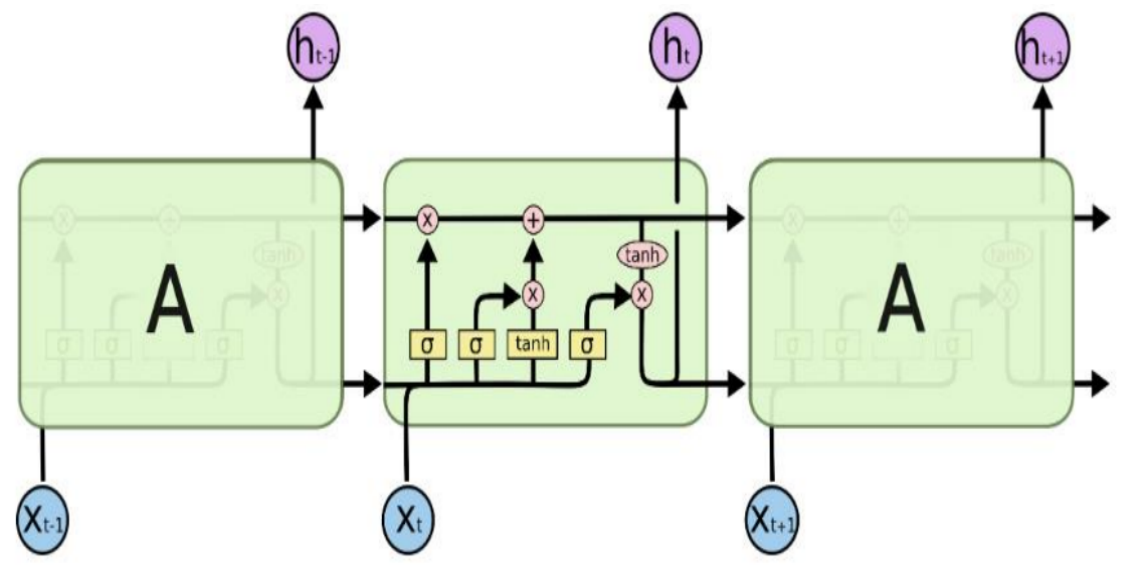
Figure 7. Framework 3-LSTM working